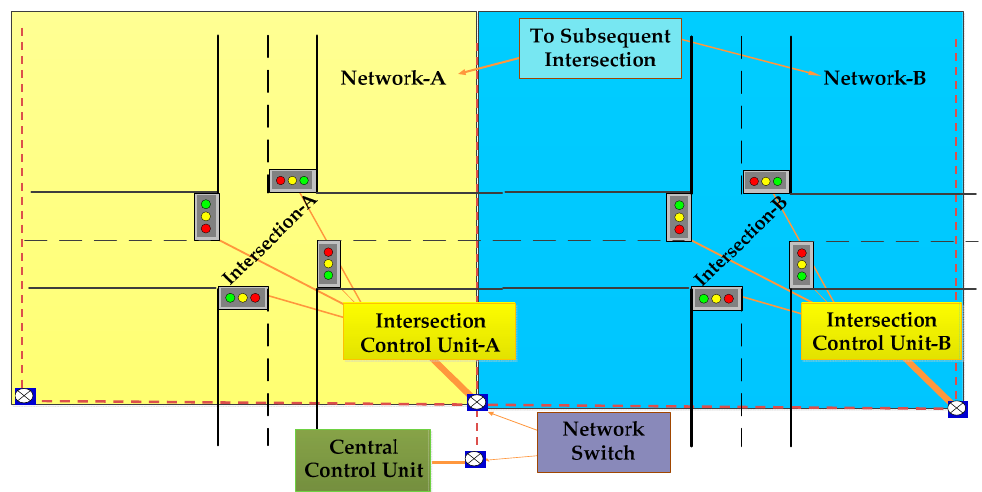
Figure 7. Priority based intelligent traffic management system.